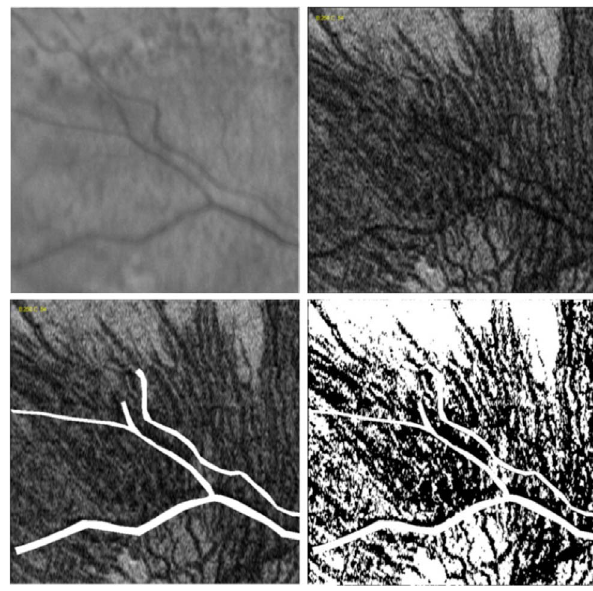
Figure 2. Infrared reflectance (IR) image (top left), En Face SD OCT Choroidal Sub-Layer C-Scan (top right). C-scan image with areas corresponding to the retinal vessels removed using ImageJ software (visible in white, bottom left), and pixel intensity thresholded C-scan using ImageJ software (choroidal vessels in black; bottom right)